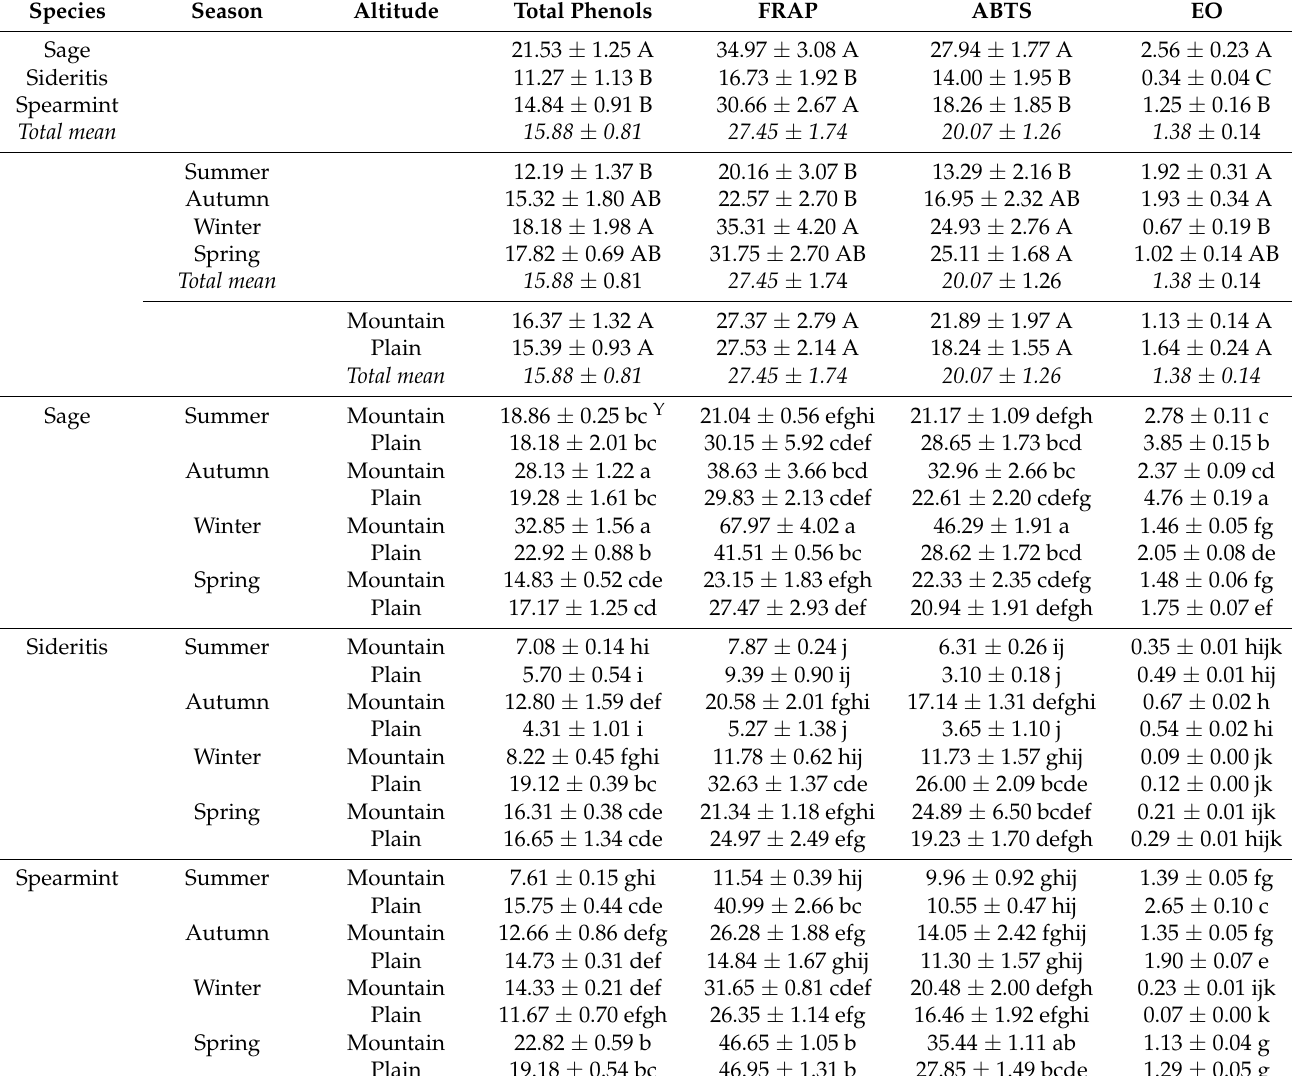
Y values (means ± SE, n = 4) in columns corresponding to the main factors (Altitude, Seasons and Species) followed by the same uppercase letter, and values corresponding to the interaction of the main factors (Altitude, Seasons and Species), which are followed by the same lowercase letter, are not significantly different, p <